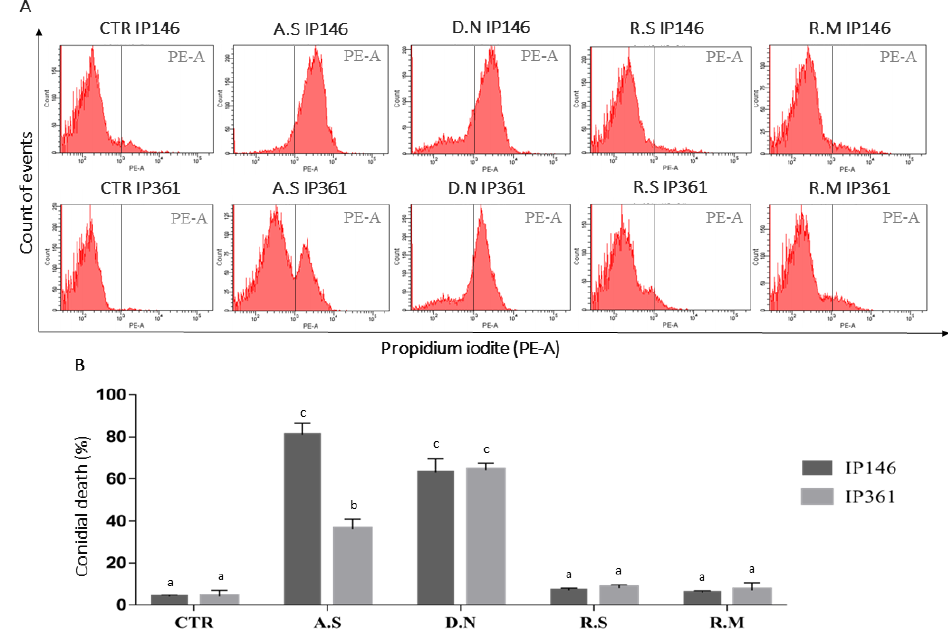
Figure 2. ( A ) Representative histograms showing the effects of cuticle extracts to conidia of Metarhizium robertsii IP 146 or Beauveria bassiana IP 361, treated or not treated (CTR: control) by immersion during 12 h, followed by flow cytometric analysis. ( B ) Percentage of conidial death in M. robertsii IP146 or B. bassiana IP361 after treatment with extracts from cuticle of Amblyomma sculptum (A.S), Dermacentor nitens (D.N), Rhipicephalus microplus (R.M) or Rhipicephalus sanguineus s.l. (R.S). Bars with the same letter do not differ significantly ( p > 0.05) by analysis of variance (ANOVA) followed by the Student-Newman-Keuls (SNK) test. Each bar represents the mean of three independent experiments.